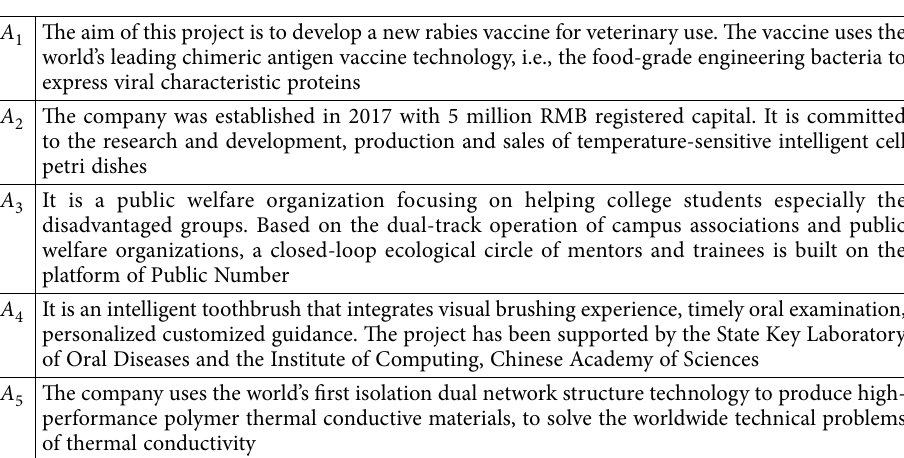
Table 4. Brief descriptions of the five investment projects